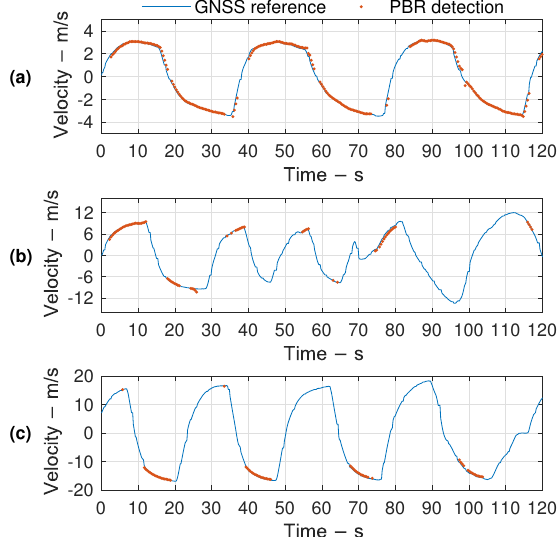
Figure 9. Bistatic velocity of detection and the GNSS reference: ( a ) beam a, ( b ) beam b, and ( c ) beam c.